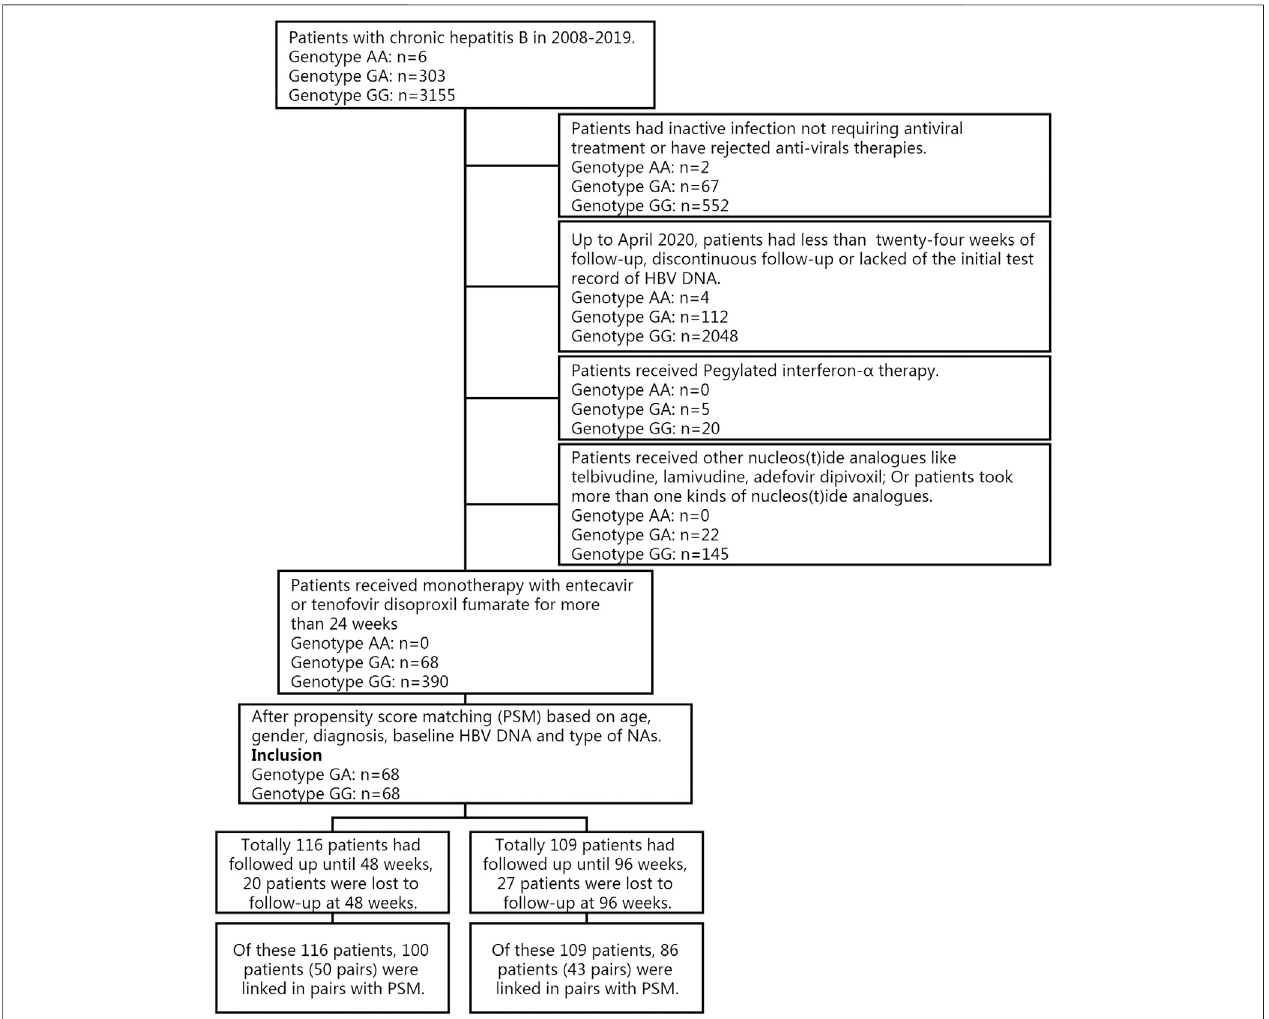
FIGURE 1 | Flow chart of subjects enrollment for whose data were